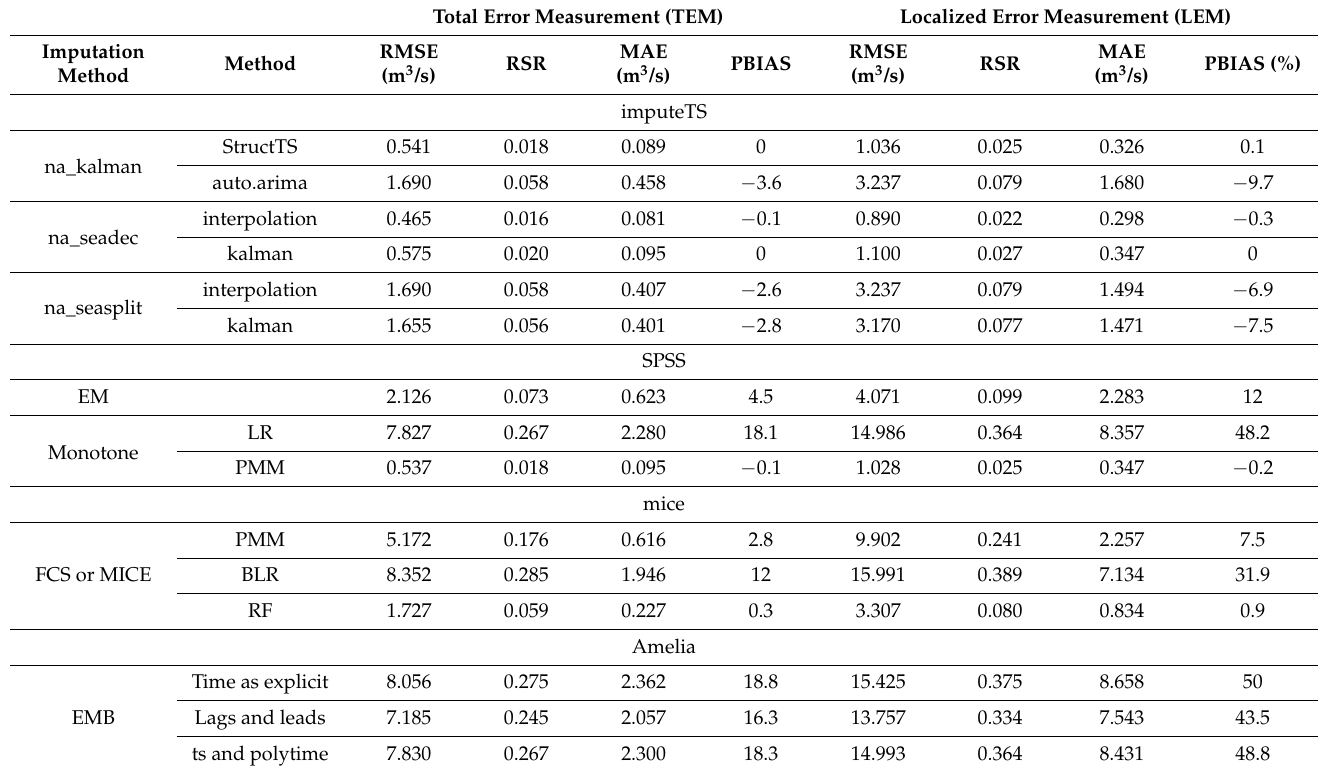
Table 6. Imputation accuracy statistics of the different missing data reconstruction